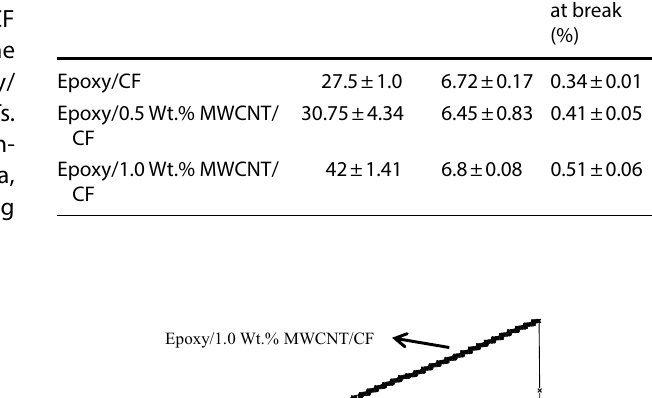
Table 1 The transverse mechanical properties of samples